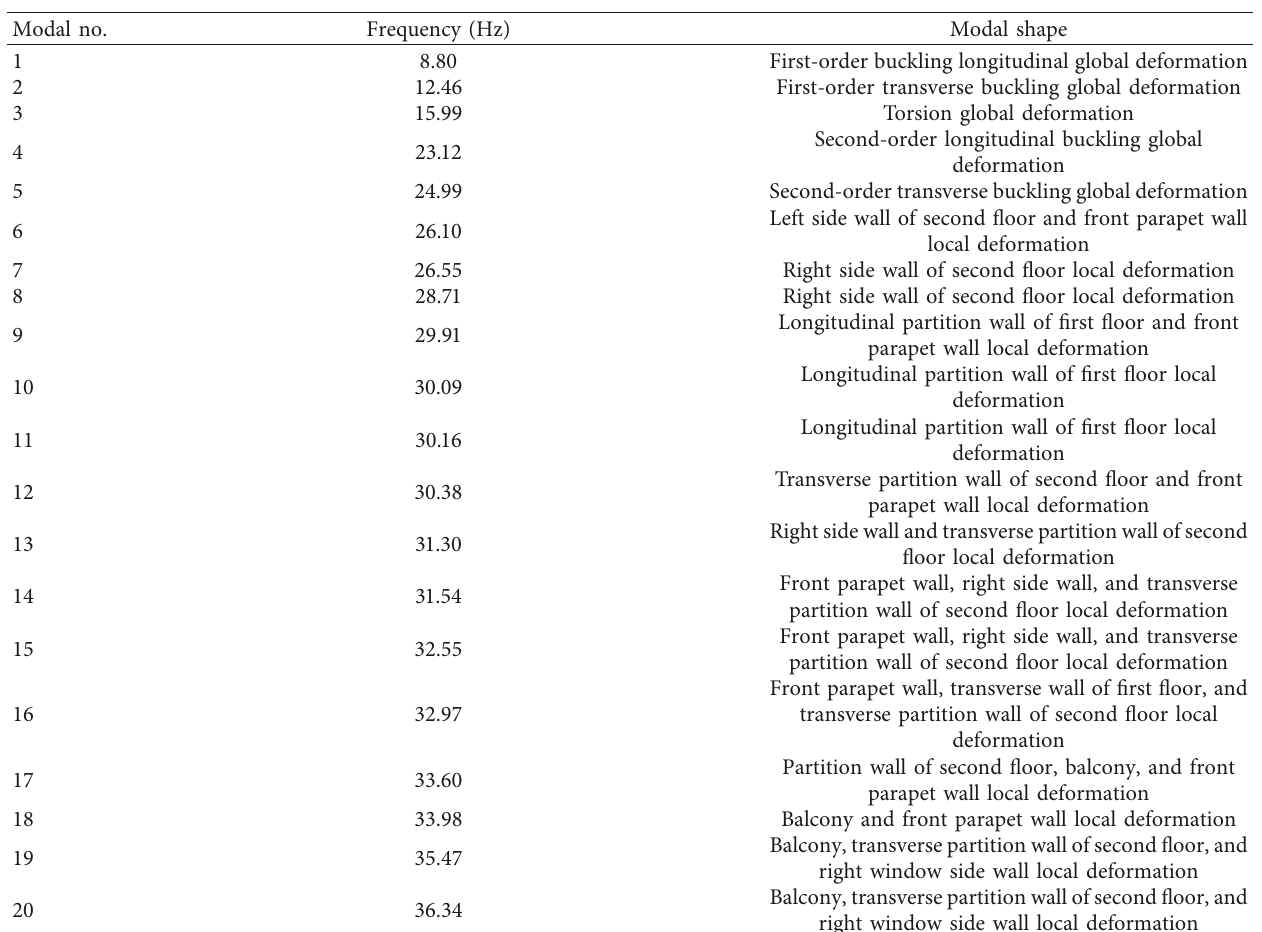
Table 5: Natural frequencies of the masonry building for initial and updated models. Modal